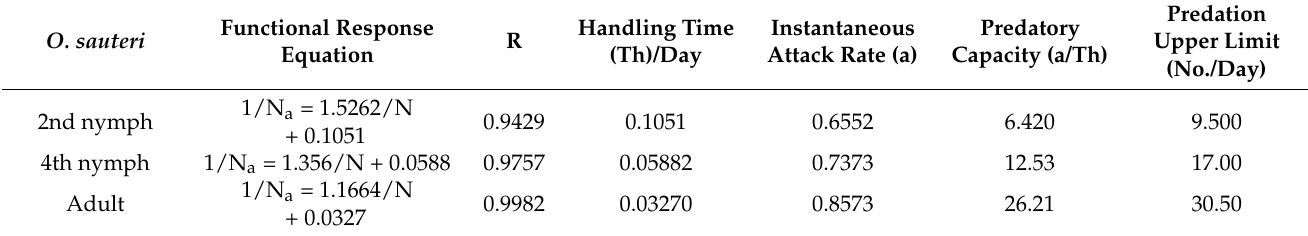
Figure 1. Predatory functional responses of O. sauteri on 2nd nymph, 4th nymph, and adult stage for adult tea thrips. Table 1. Predatory functional responses of O. sauteri preying on tea thrip adults.